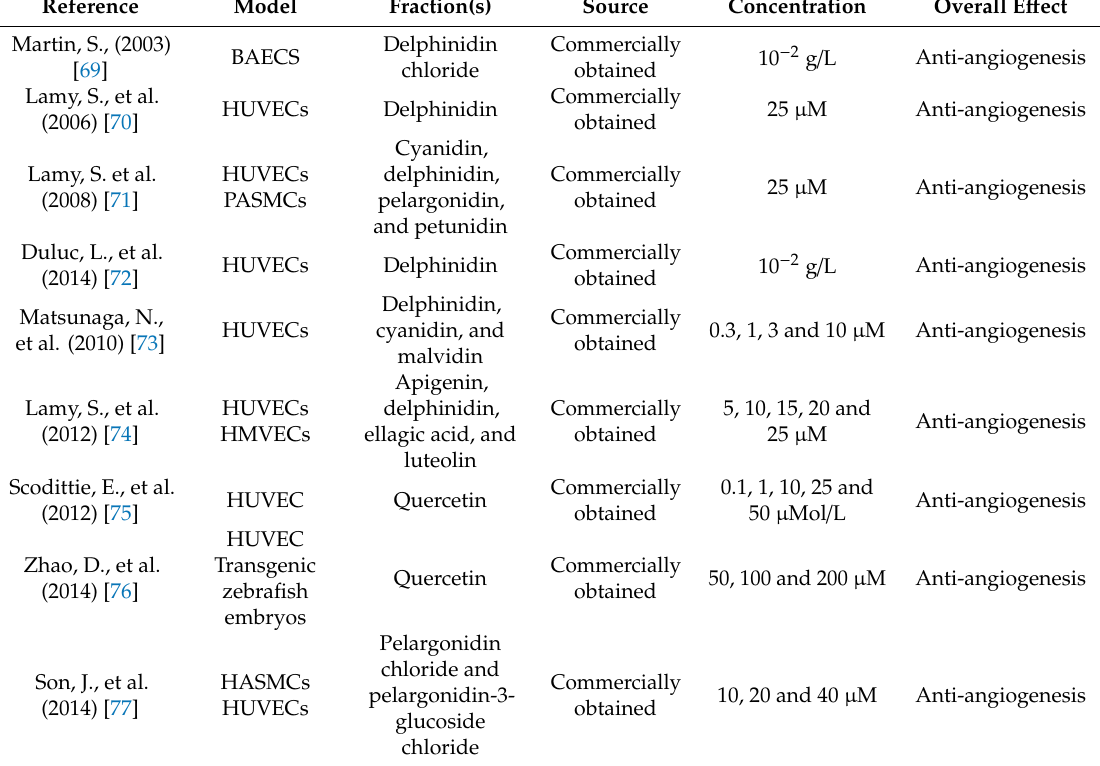
Table 1. Role of anthocyanins on cell migration and